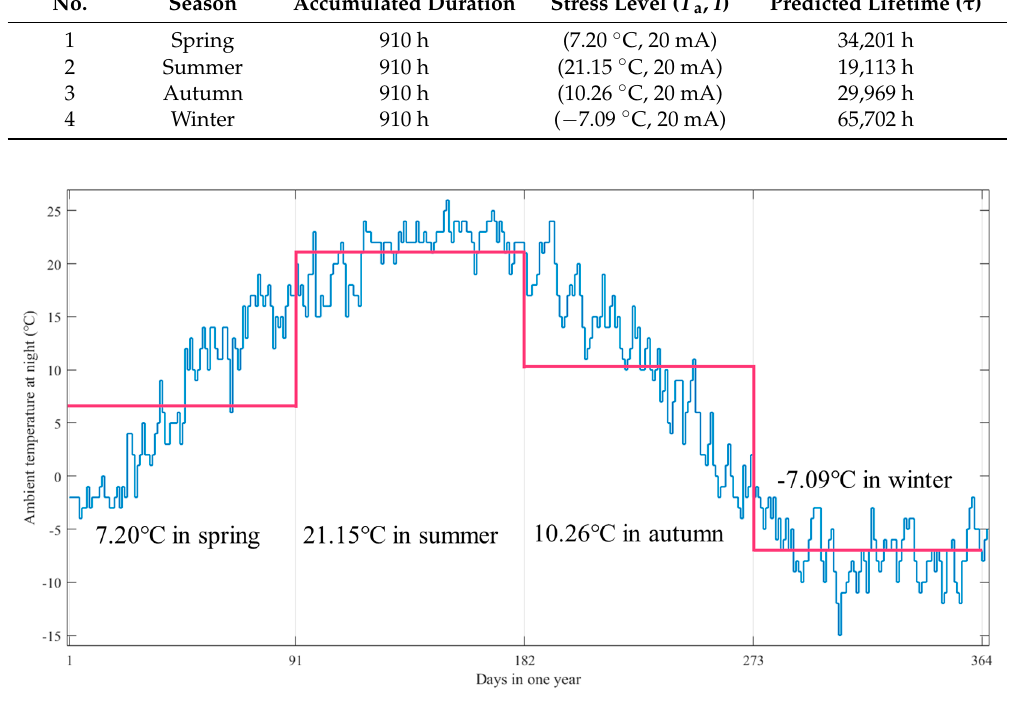
Figure 4. The average ambient temperature at night every day in Beijing.